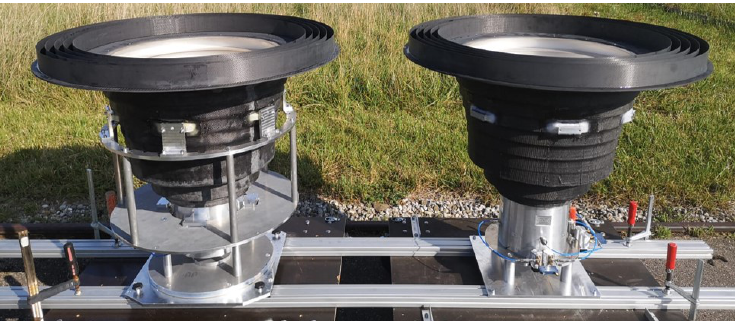
Figure 4. Outdoors coupling measurement setup with two CFK VEGA antennas and CFK choke rings. Shown in the figure is the mechanical setup without the VNA, which was used to measure all coupling parameters. The distance between the antennas was varied to evaluate the choke rings’ effectiveness in relation to distance and